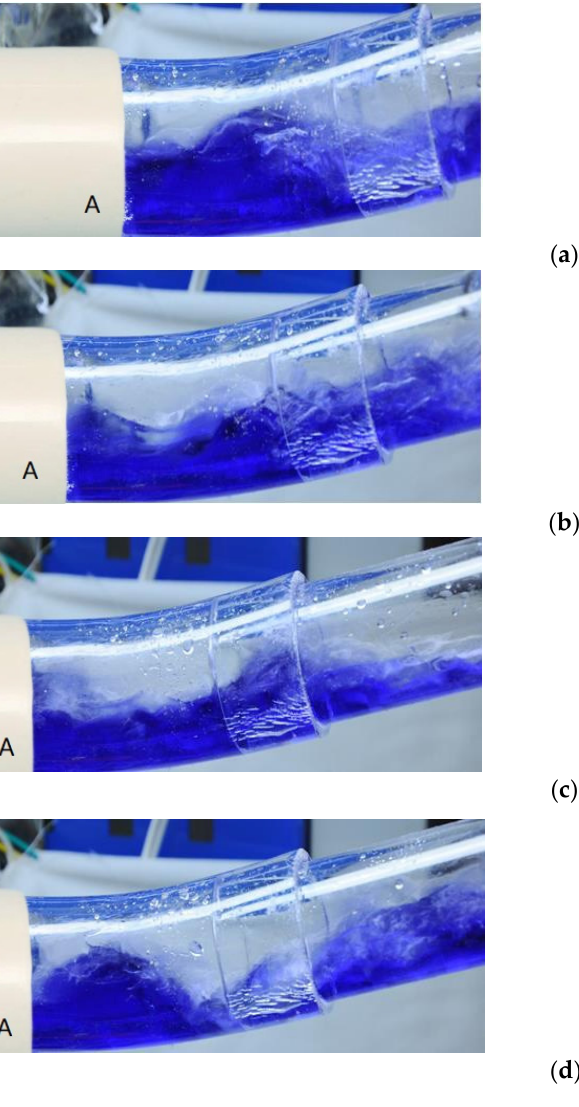
Figure 14. Slug flow pipeline pressure distribution 20°: ( a ) flow image in the pipeline at point A and P 4 at time t 1 ; ( b ) flow image in the pipeline at point A and P 4 at time t 2 ; ( c ) flow image in the pipeline at point A and P 4 at time t 3 ; ( d ) flow image in the pipeline at point A and P 4 at time t 4 .